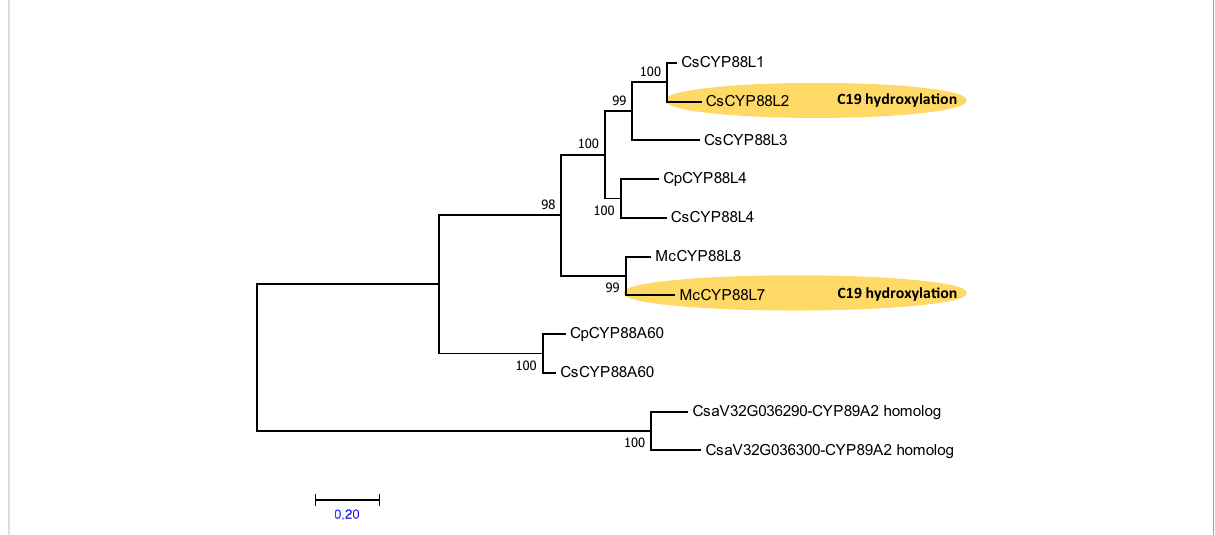
FIGURE 6 Phylogenetic analysis suggests that the P450 s the C19 hydroxylation in cucurbitadienol from Cucumis sativus and Momordica charantia evolved independently within the Cucurbitaceae. Maximum Likelihood tree constructed on deduced amino acid sequences aligned by ClustalW spanning 260 positions using MEGA7 program. The statistical signi fi cance of each node was tested by the bootstrap method using 1,000 iterations. Representative names are as follows: CsCYP88L3, Cucumis sativus uncharacterized P450; CsCYP88L1, Cucumis sativus uncharacterized P450; CsCYP88L2, P450 making cucurbitadienol C19 hydroxylation; CpCYP88L4, Cucurbita pepo CYP88L4 homolog; CsCYP88L4, Cucumis sativus uncharacterized P450; McCYP88L8, Momordica charantia P450 making cucurbitadienol C7 hydroxylation; McCYP88L7, Momordica charantia P450 making cucurbitadienol C19 and C7 hydroxylation; CpCYP88A60, Cucurbita pepo putative ent- kaurenoic acid hydroxylase; CsCYP88A60, Cucumis sativus putative ent-kaurenoic acid hydroxylase; CsCYP89A2-homologs, Cucumis sativus used as outgroup. Accession number of sequences are given in Table S5. Two Cucumis sativus sequences homologous to Arabidopsis thaliana CYP89A2 were used as an